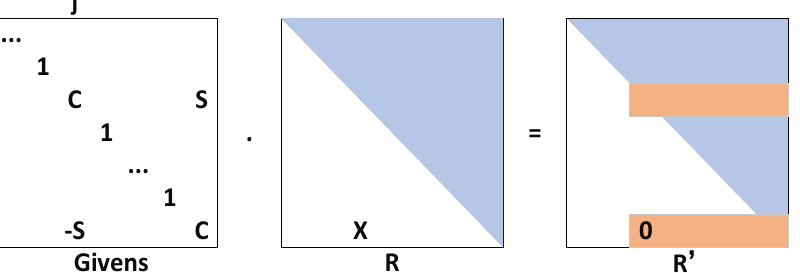
Figure 1. Givens matrix incremental update. (Using the Givens rotation matrix, a matrix is trans- formed into upper triangular form. Elements marked with X are eliminated, and elements marked with red are changed).